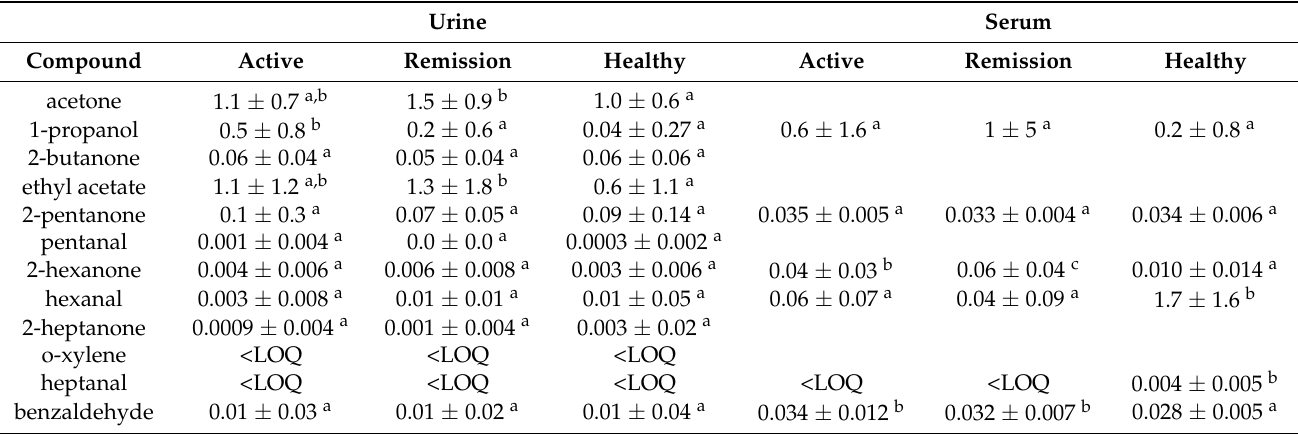
Table 4. Average concentrations ( µ g mL − 1 ) and standard deviation of identified VOCs in each category, including results of LSD test for urine and serum